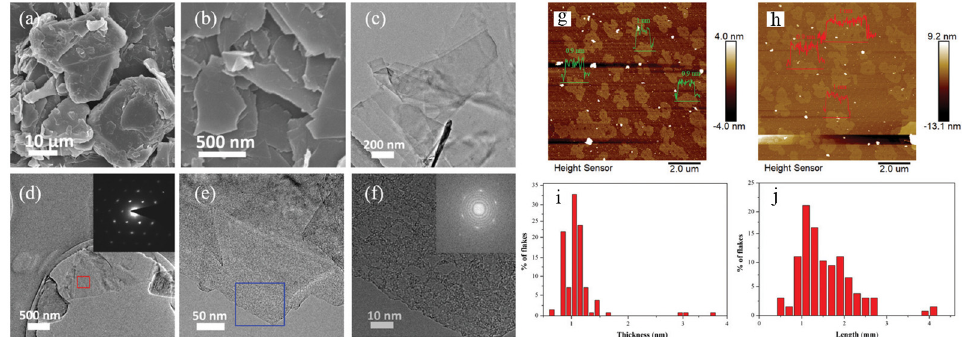
Figure 3. Microscopic morphology photos of gas-driven exfoliated graphene. SEM images of ( a ) graphite powder, ( b ) gas-driven exfoliated graphene. ( c ) Wide-field TEM image of gas-driven exfoliated graphene. ( d , e ) Representative monolayer flakes; inset in image ( d ) shows the selected area electron diffraction (SAED) pattern of the red-marked box. ( f ) HR-TEM image of blue-marked box in image ( e ); inset shows corresponding fast Fourier transform (FFT) pattern. ( g , h ) AFM images of gas-driven exfoliated graphene. ( i ) Thickness distribution of graphene. ( j ) Length distribution of graphene [60]. Reprinted with permission from ref. [60]. Copyright 2019 Royal Society of Chemistry.